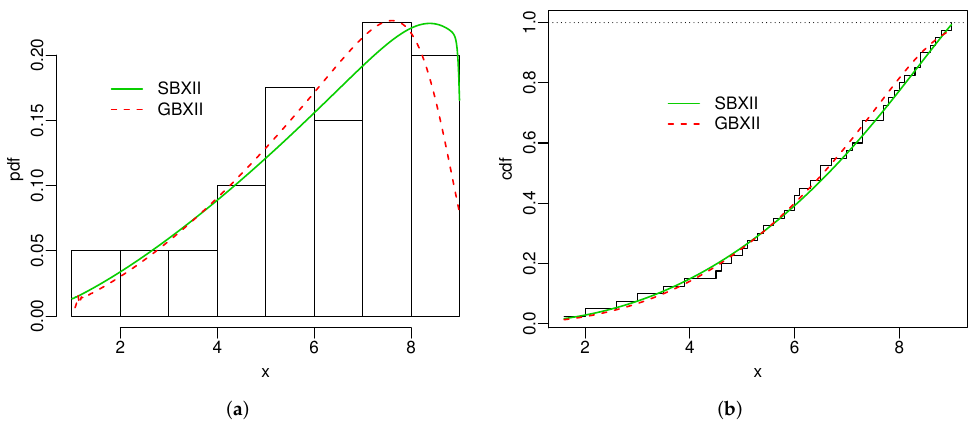
Figure 5. Estimated pdfs ( a ) and estimated cdfs ( b ) for turbocharger data. Figures 6 and 7 display plots of the profile log-likelihood function versus some param- eter values (the MLEs of the other parameters fixed) for the skin folds and turbocharger data, respectively. We can find the approximate intervals that maximize the profile log- likelihood function for each parameter. In Figure 6a, the log-likelihood is maximized for values of a close to one. Similarly, it takes maximum values for 0 < b < 10, 15 < s < 50, 0.0014 < d < 0.05, and 0 < c < 40 according to Figure 6b–e, respectively. The interpretation from Figure 7 is analogous. Nevertheless, there is evidence of a monotone log-likelihood in Figure 7b since this function does not have a maximum in the range taken for b .